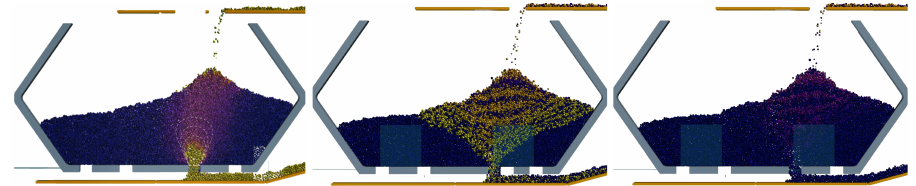
Figure 13. The spatial distribution of velocity ( left ), concentration ( centre ) and hardness ( right ) in the pile at a time instant. The material that will be discharged in the near future may be estimated from the funnel flow zone ( left ).